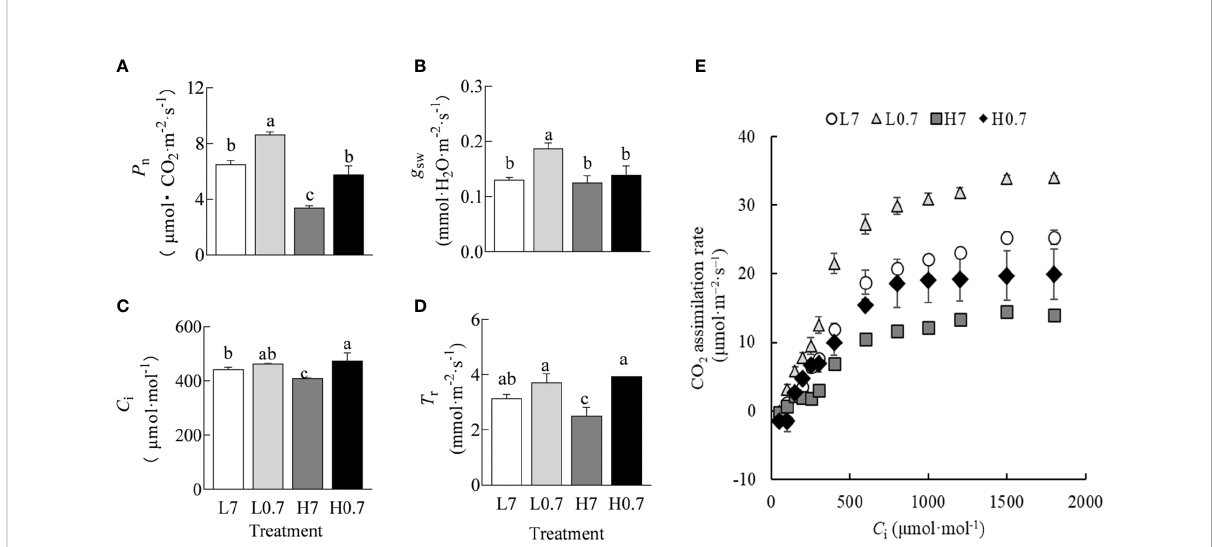
FIGURE 3 Effect of R/FR on gas exchange parameters in cucumber leaves under salt stress. (A) , P n , CO 2 assimilation rate; (B) , g sw , stomatal conductance; (C) , C i , intercellular CO 2 concentration; (D) , T r , transpiration rate; (E) , CO 2 response curve. All data in (A – E) were reported as the arithmetic mean ± standard error (n=4 and n=3,